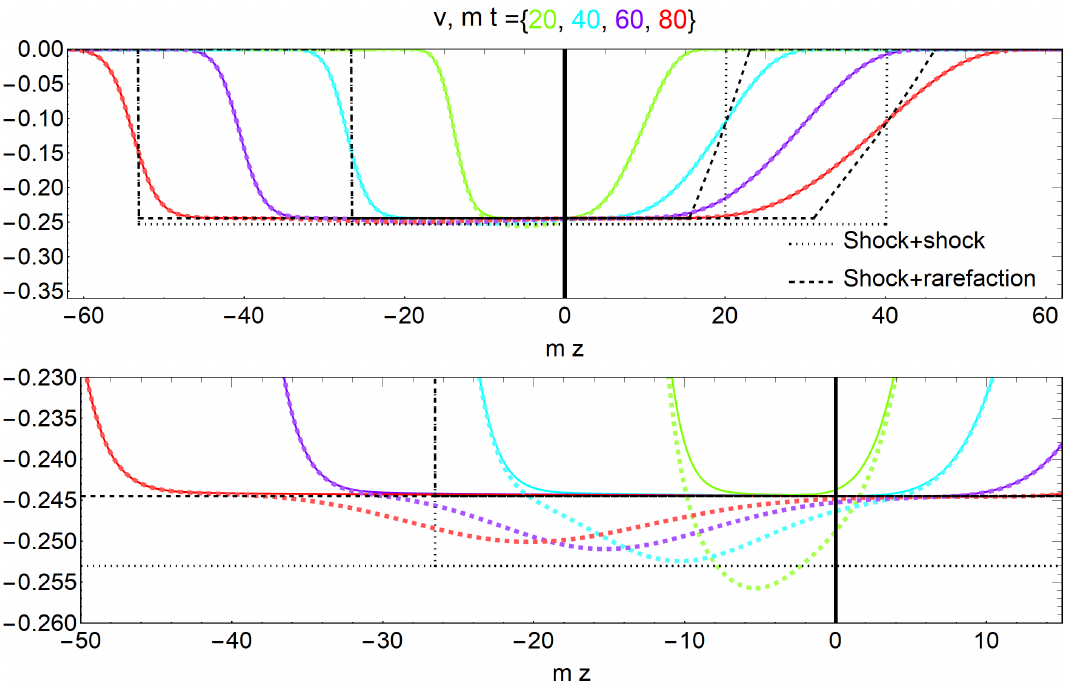
Figure 7: Snapshots of the local fluid velocity (solid) and charge velocity (dashed) at four different times for the same evolution as in Fig. 5. The bottom panel shows a magnification of the upper panel, where the velocity profile of the charge diffusion at the contact discontinuity of the two charge plateaus is clearly